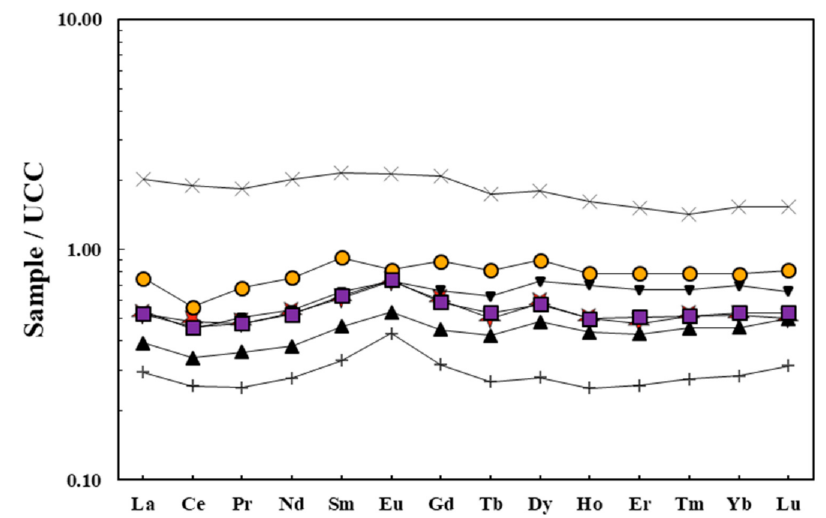
Figure 4. REE distribution of the separated fractions according to grain size and magnetic suscepti- bility (UCC normalization after [26]). Symbols as in Figure